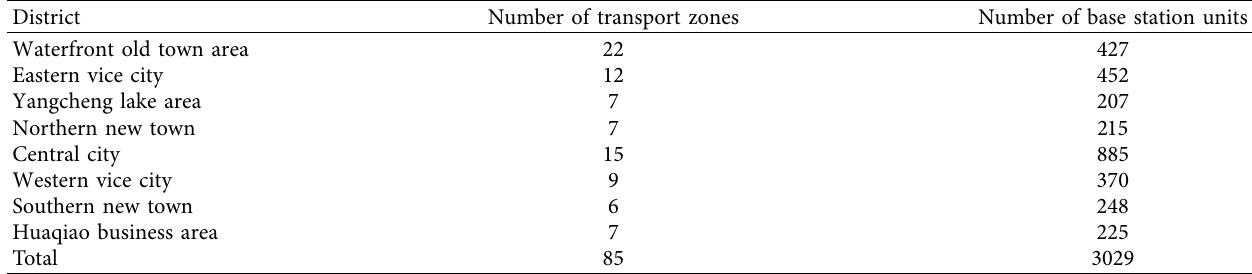
Table 2: Statistical table of study area